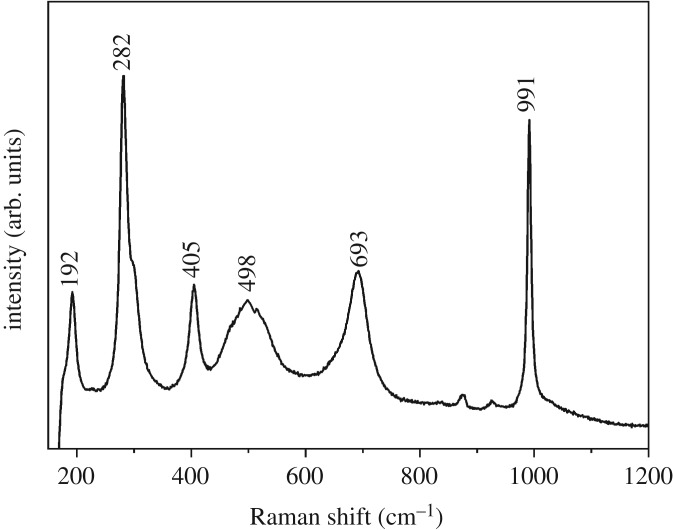
Raman spectrum of as-synthesized VO2.